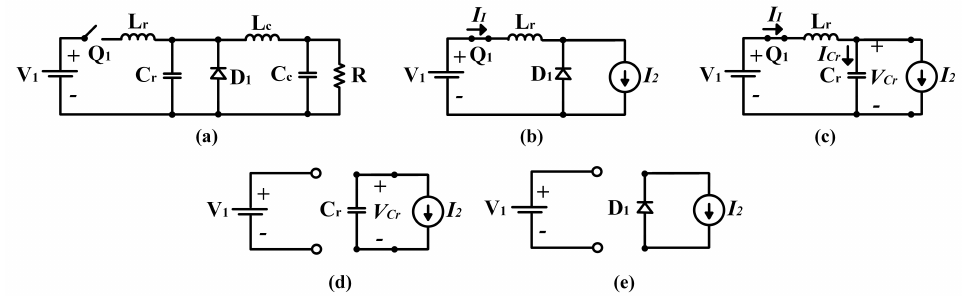
Figure 6. Topology and operation modes: ( a ) quasi-resonant buck converter, ( b ) charging of L r , ( c ) resonant mode, ( d ) discharging of L r , and ( e ) freewheeling mode.